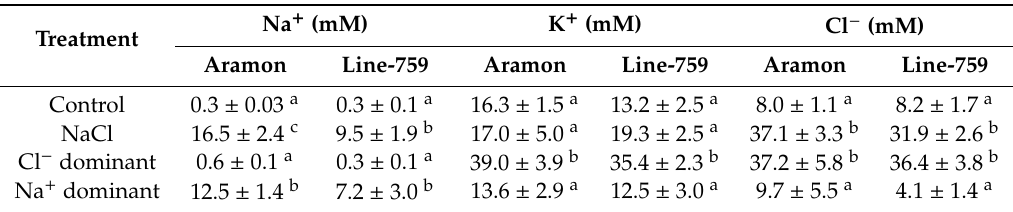
Table 3. Ion concentration of xylem saps of cucumber genotypes “Aramon” and “Line-759” treated with NaCl, Cl − , and Na + dominant solution during three weeks. Values are means ± SD ( n = 5). Means followed by the same letter are not significantly di ff erent at p = 0.05 according to the Tukey Honest Significant Di ff erences